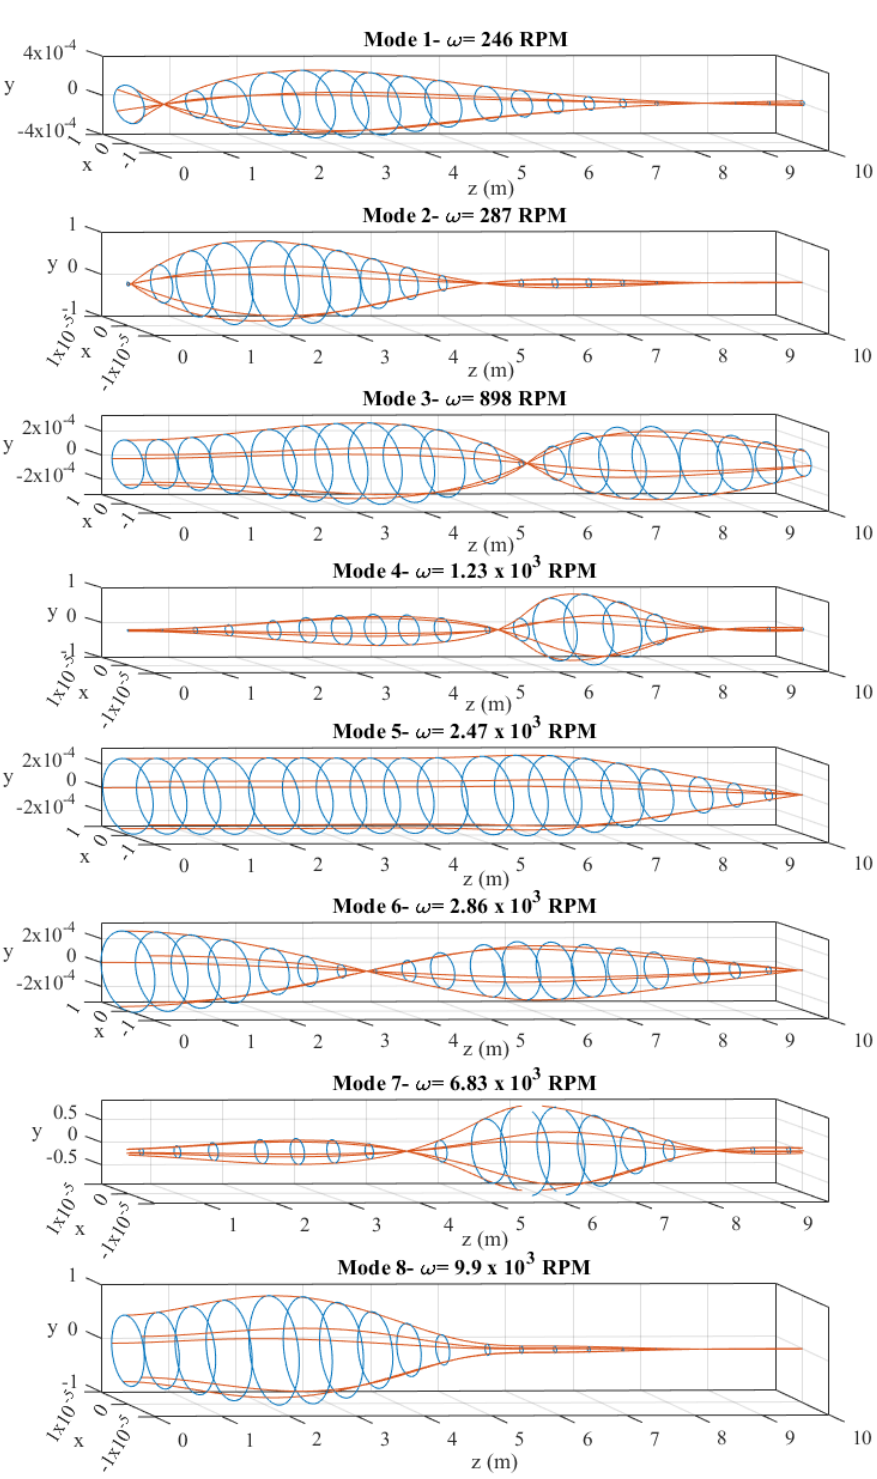
Figure 7. Eight lowest eigenmodes at a shaft speed of 8.6 RPM. The x- and y-axes have different scales depending on the nature of each mode shape.